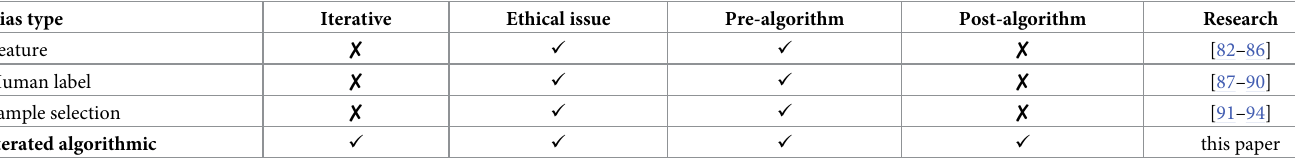
Table 1. Different bias types studied in recent research. Iterated algorithmic bias happens when an algorithm interacts with human response continuously, and updates its model after receiving feedback from the human. Meanwhile, the algorithm interacts with the human by showing only selected items or options. Other types of bias are static, which means they have a one-time influence on an